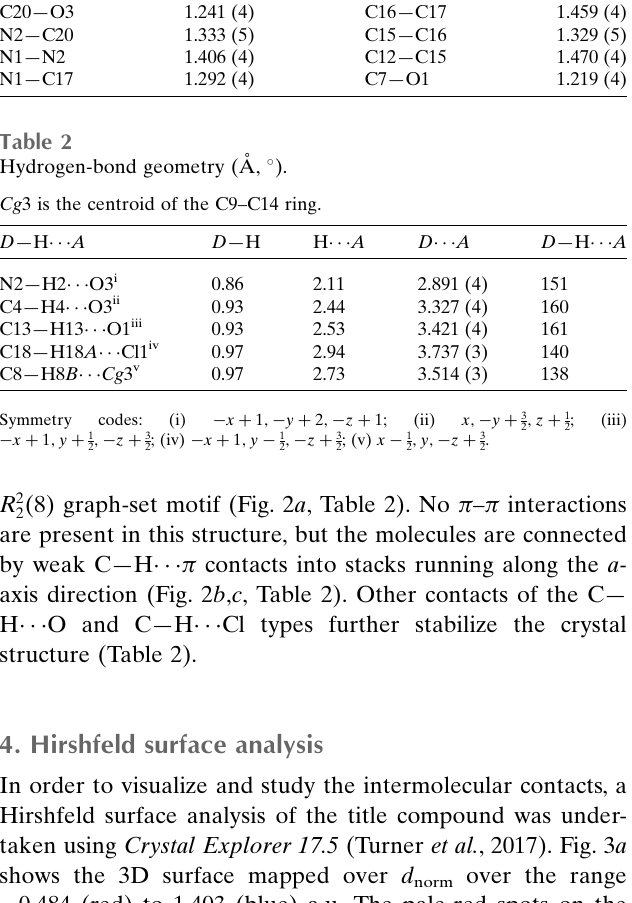
and d are presented in e i